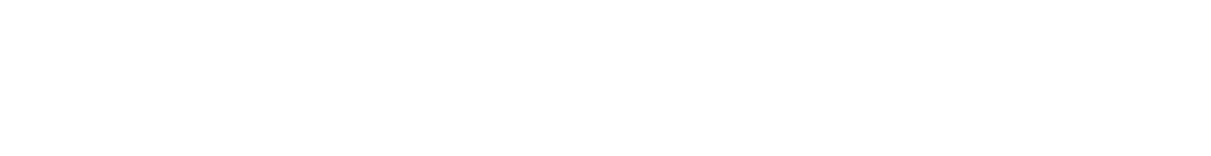
Frontiers in Bioengineering and Biotechnology |